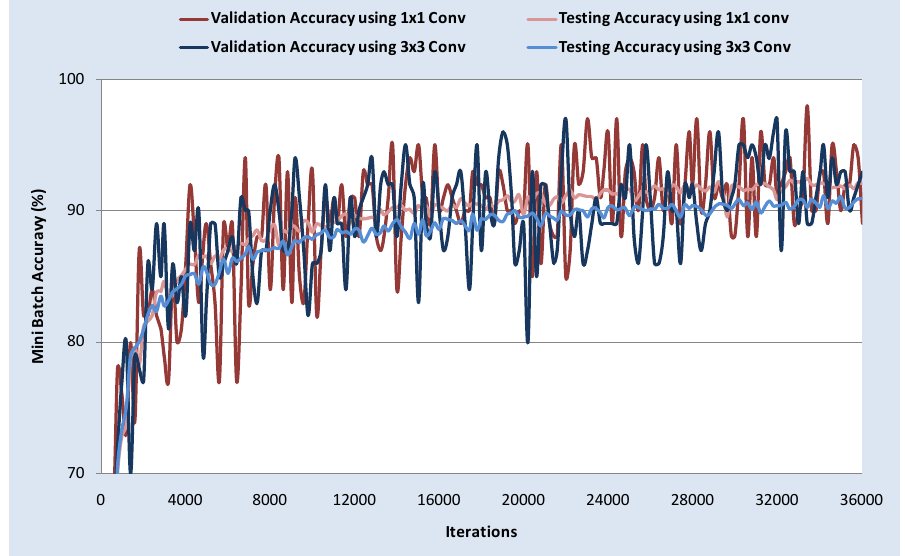
Figure 6. Analysis of Conv 1 × 1 vs. Conv 3 × 3.